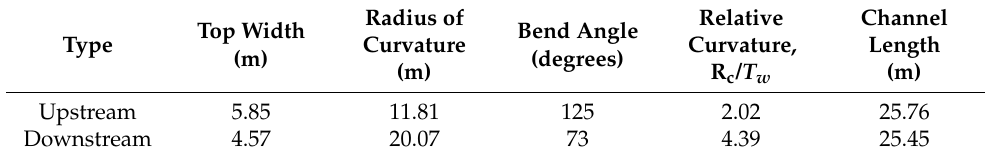
Table 1. Physical Model Bend